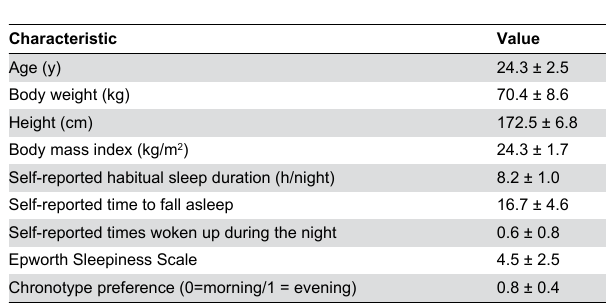
Table 1. Subject characteristics